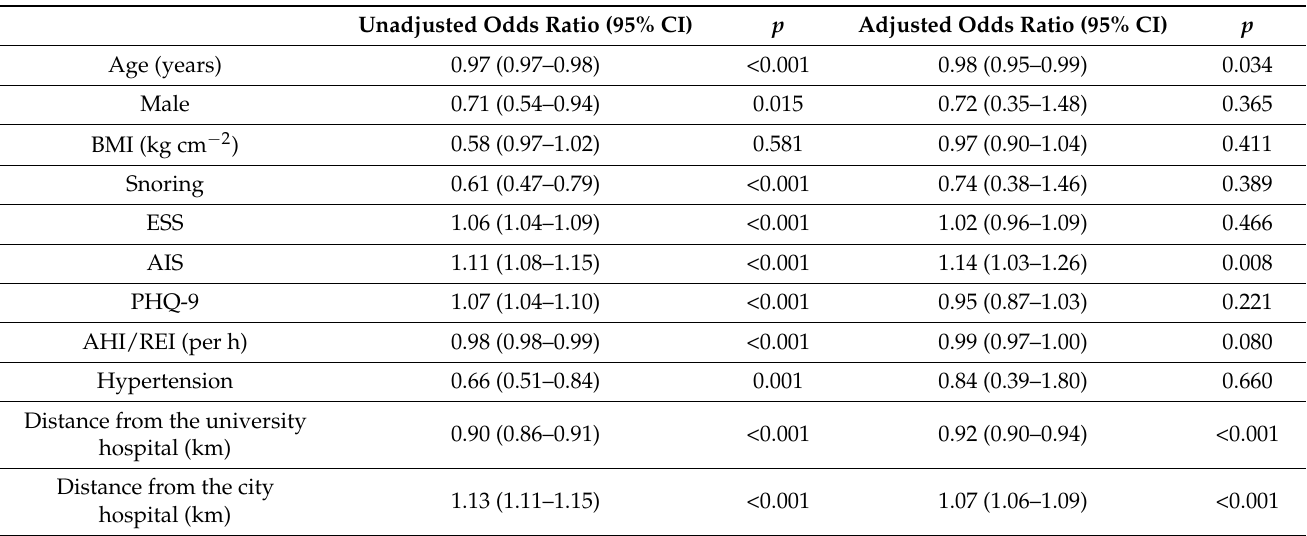
Table 3. Logistic regression analysis: comparisons between the university hospital and the